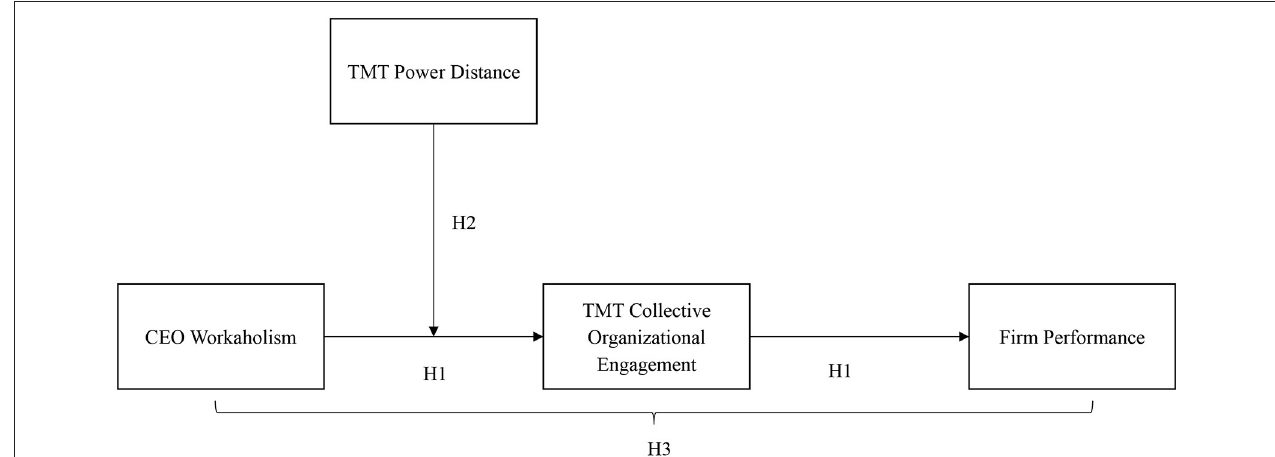
FIGURE 1 | The proposed